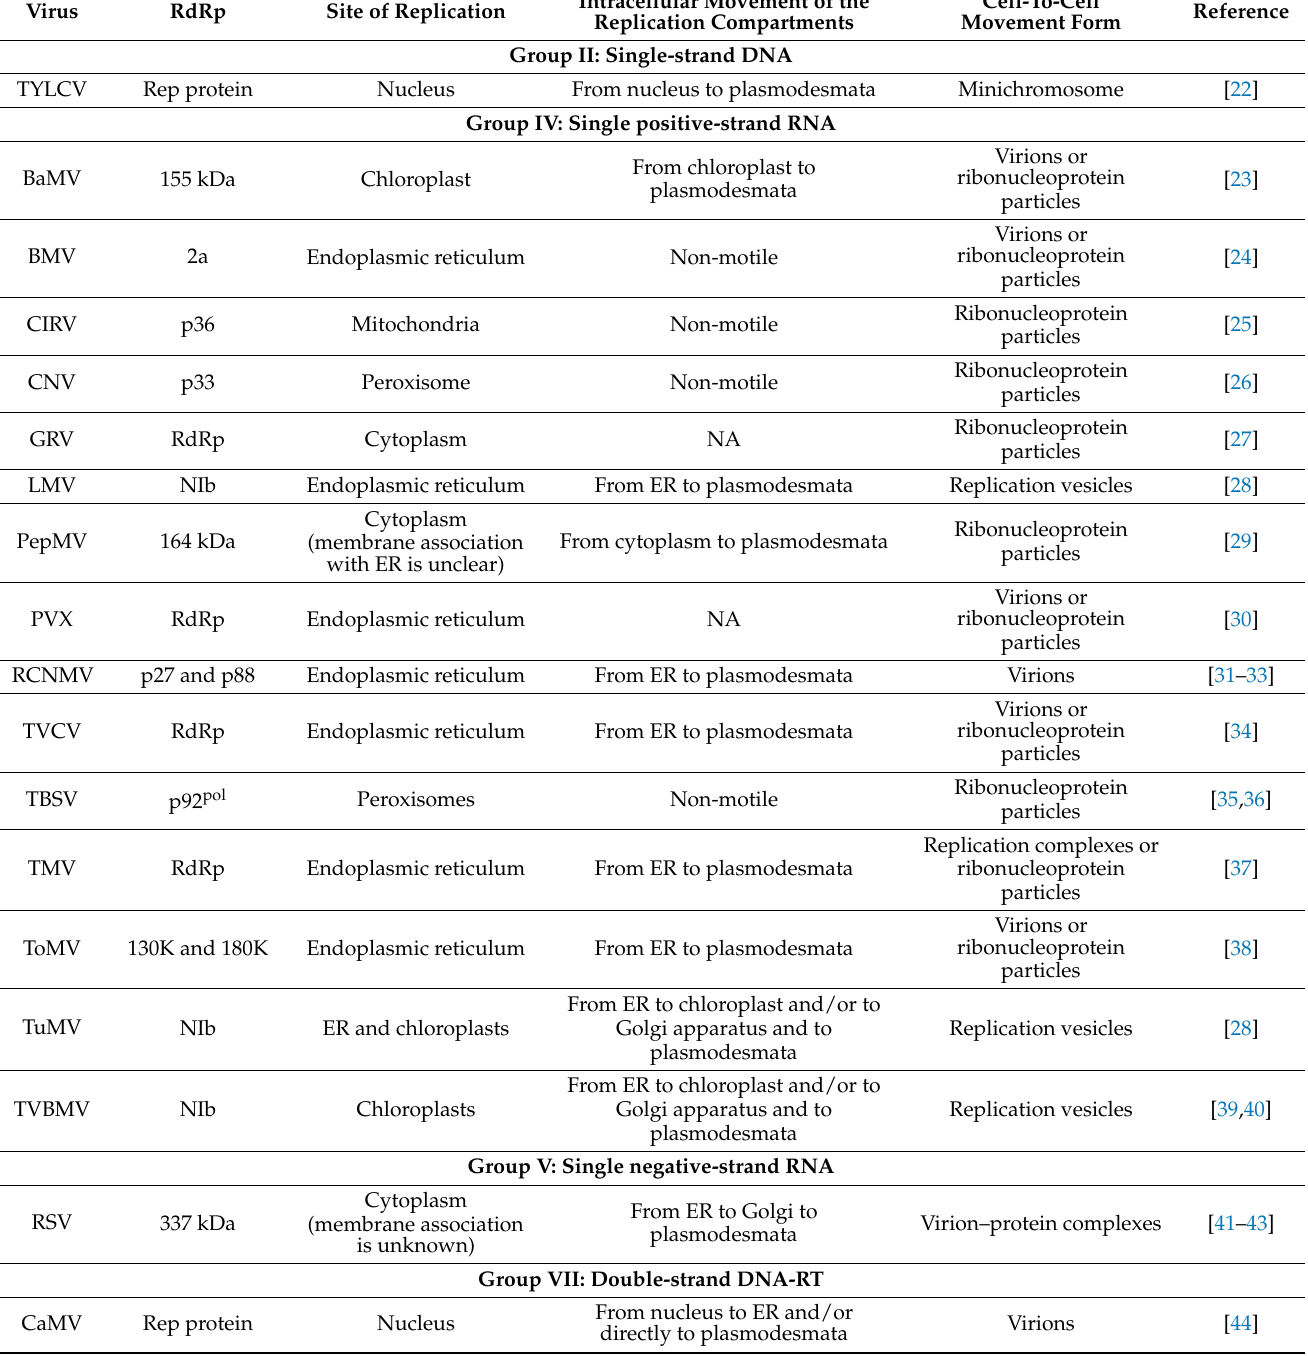
Table 1. Site of replication and movement form of plant viruses for which at least one host protein has been reported to change subcellular